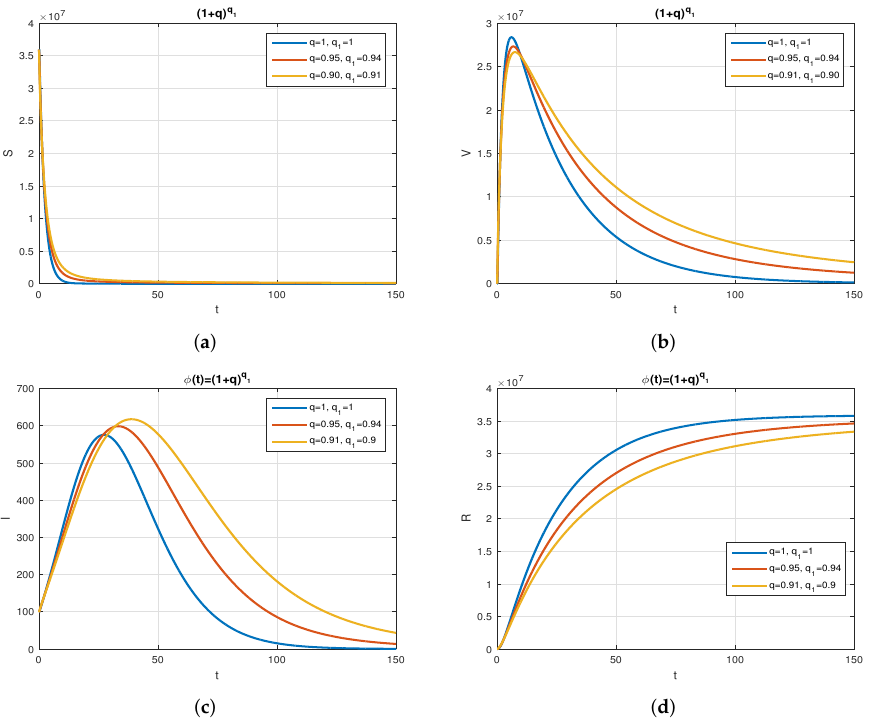
Figure 7. The behavior of the model for different values of q and q 1 with φ ( t ) = ( 1 + q ) q 1 . Subfigure ( a ) shows the simulation of the healthy population for various values of q and q 1 with φ ( t ) = ( 1 + q ) q Subfigure ( b ) shows the simulation of the vaccinated population for various values of q and q 1 with φ ( t ) = ( 1 + q ) q . Subfigure ( c ) shows the simulation of the infected population for various values of 1 q and q 1 with φ ( t ) = ( 1 + q ) q . Subfigure ( d ) shows the simulation of the recovered population for 1 various values of q and q 1 with φ ( t ) = ( 1 + q ) q 1